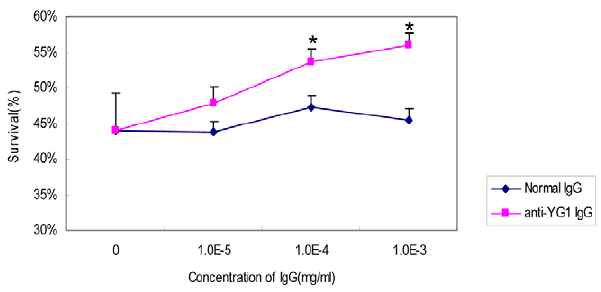
Figure 3. anti-YG1 Ab could inhibit the cytotoxicity of rhTNF- a . Various concentrations of antibodies against to YG1 and control antibodies were added to inhibit the cytotoxicity of rhTNF- a . The cytotoxicity was measured by detecting the amounts of cells by MTT. Values represent the mean 6 SD for 3 independent tests. * represent P , 0.001(anti-YG compared with normal